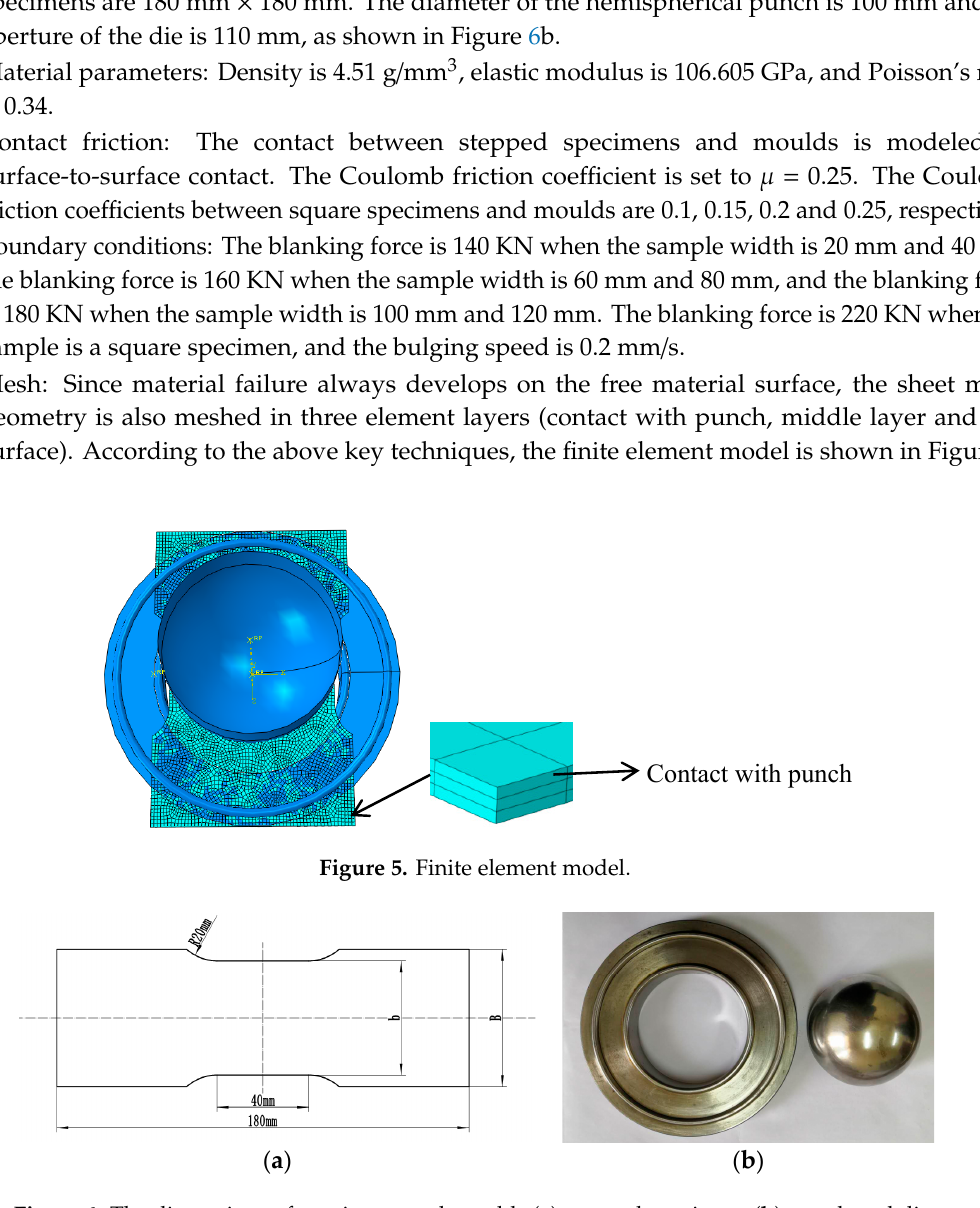
Figure 6. Finite element model.